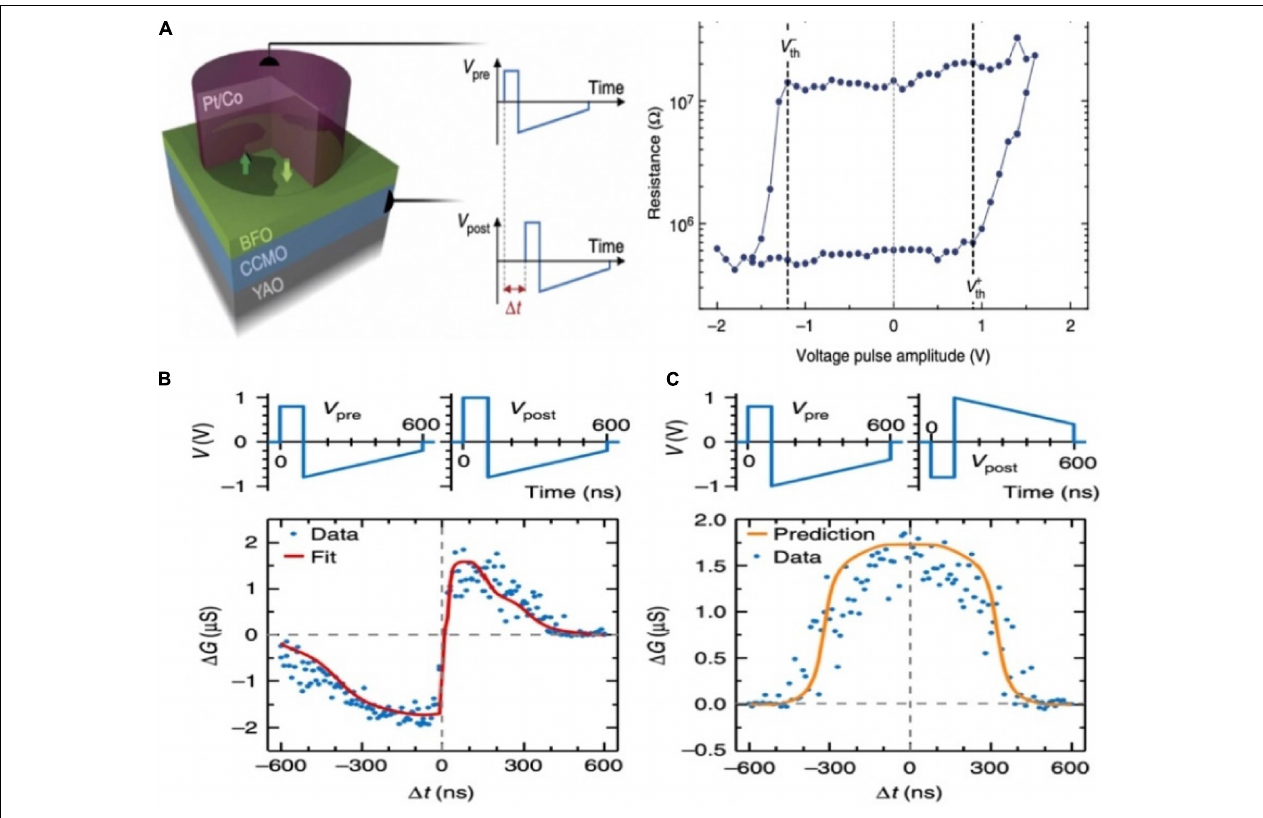
FIGURE 5 | (A) Schematic diagram of the ferroelectric memristor. (B) The single pulse hysteresis loop of the memristor shows clear voltage thresholds. (C) STDP learning curves of different shapes (adapted from Boyn et al.,